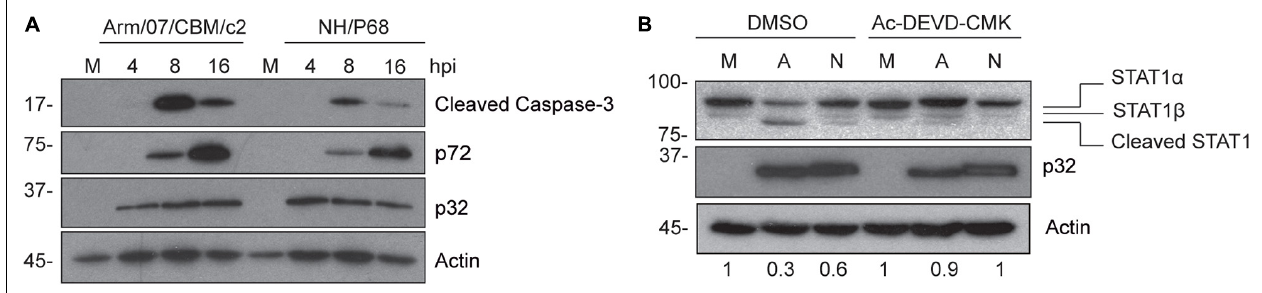
FIGURE 6 | STAT1 is cleaved during caspase-3 activation induced by Arm/07/CBM/c2 and NH/P68 infection. PAM cells were mock infected (M) or infected with Arm/07/CBM/c2 (Arm) or NH/P68 ASFV strains (3 PFU/cell). Cells were collected at 4, 8, and 16 hpi, lysed in RIPA buffer and analyzed by Western blot (A) . Antibodies against cleaved caspase-3, early viral protein p32, actin and pig serum 1262 to detect late p72 viral protein were used. PAMs were mock infected (M) or infected with Arm/07/CBM/c2 (A) or NH/P68 (N) ASFV strains (3 PFU/cell) in absence or in presence of the caspase-3 inhibitor Ac-DEVD-CMK (80 µ M). At 16 hpi, cells were collected and lysed for the Western blot analysis (B) . Antibodies against STAT1, early viral protein p32 and actin were used. The Western blot bands corresponding to STAT1 α (91 kDa) were quantified according with their actin levels and relativized with the corresponding mock control using ImageJ. STAT1 α (91 kDa), STAT1 β (84 kDa) and cleaved STAT1 (80 kDa) bands are highlighted in the